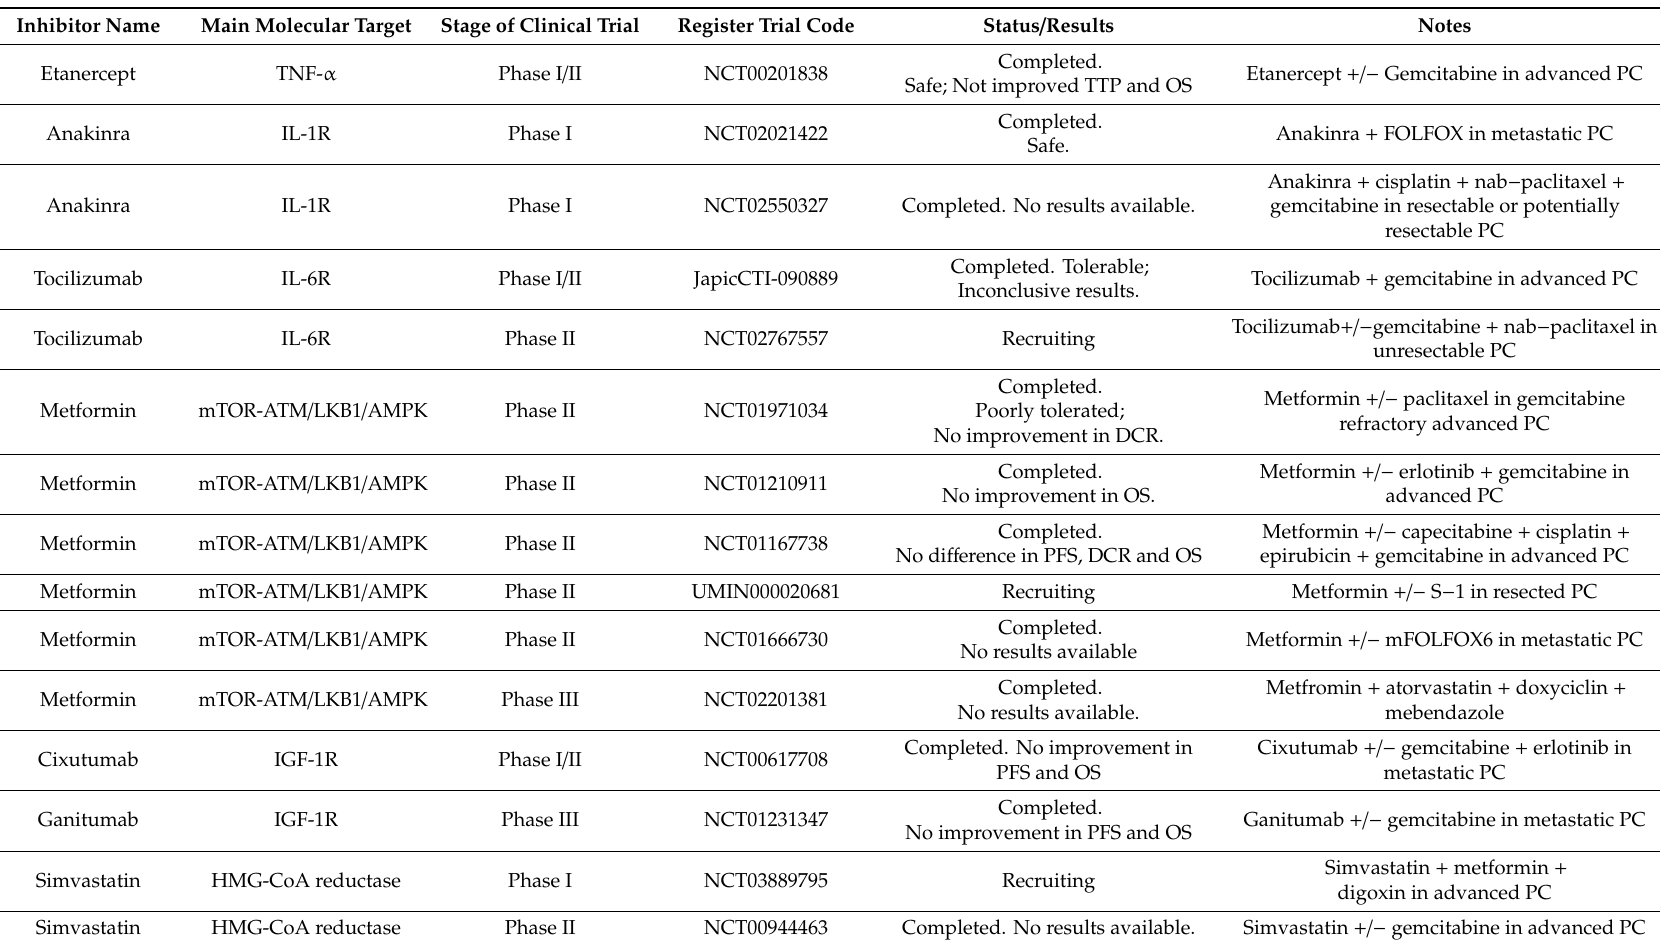
Table 2. Overview of ongoing and completed clinical trials investigating potential targets involved in the crosstalk between adipose tissue and